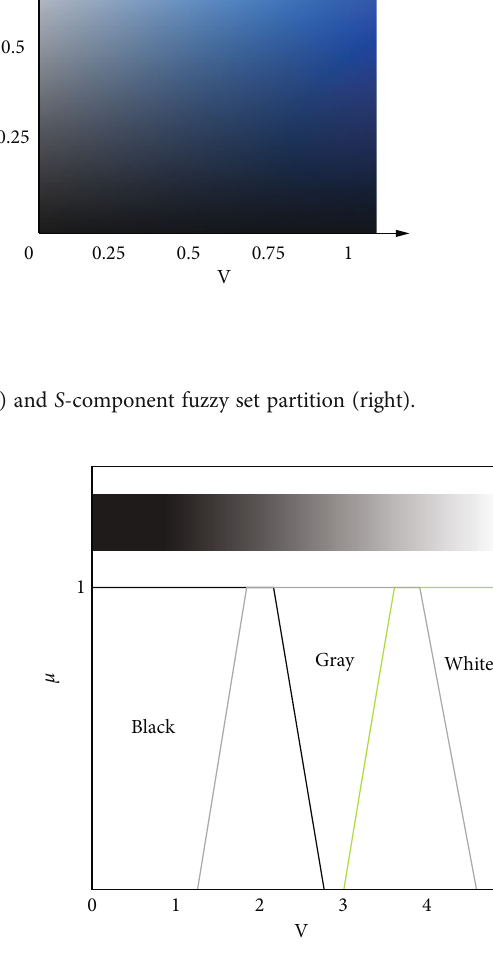
Figure 6: Plot of ceramic material color as a function of V and V -component fuzzy set